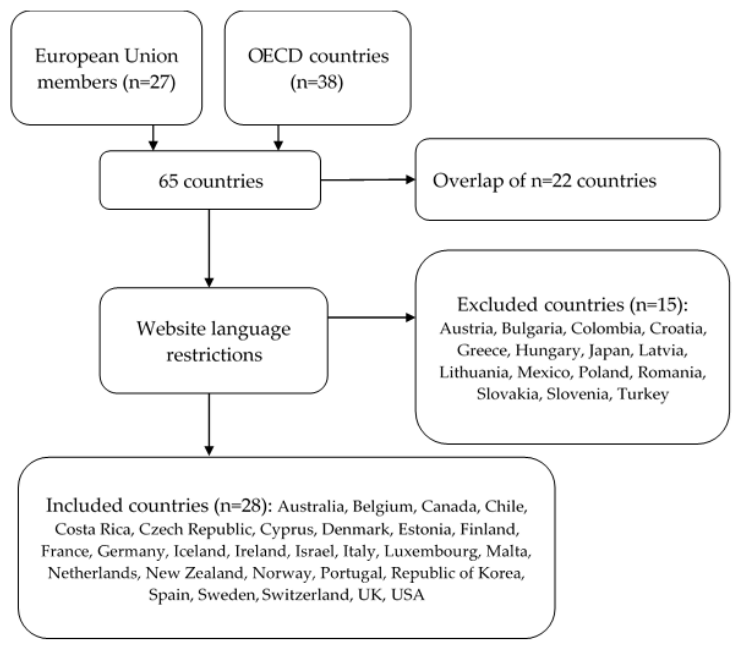
Figure 1. Countries included in the study. Table 1. Starting date of booster dose